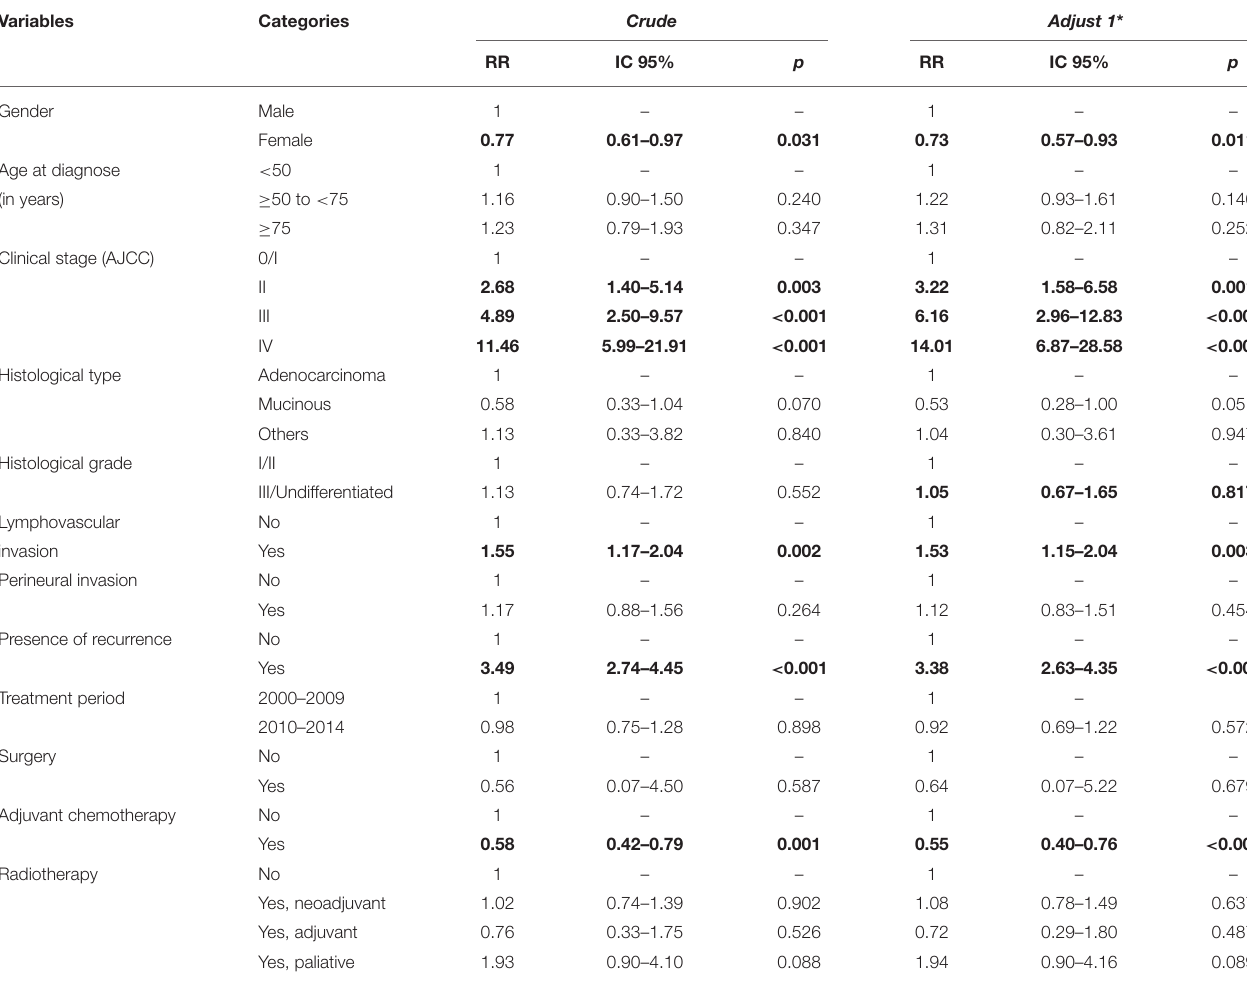
TABLE 5 | Multivariate analysis of cancer-specific survival associated with different clinicopathological characteristics and treatment of patients with colorectal